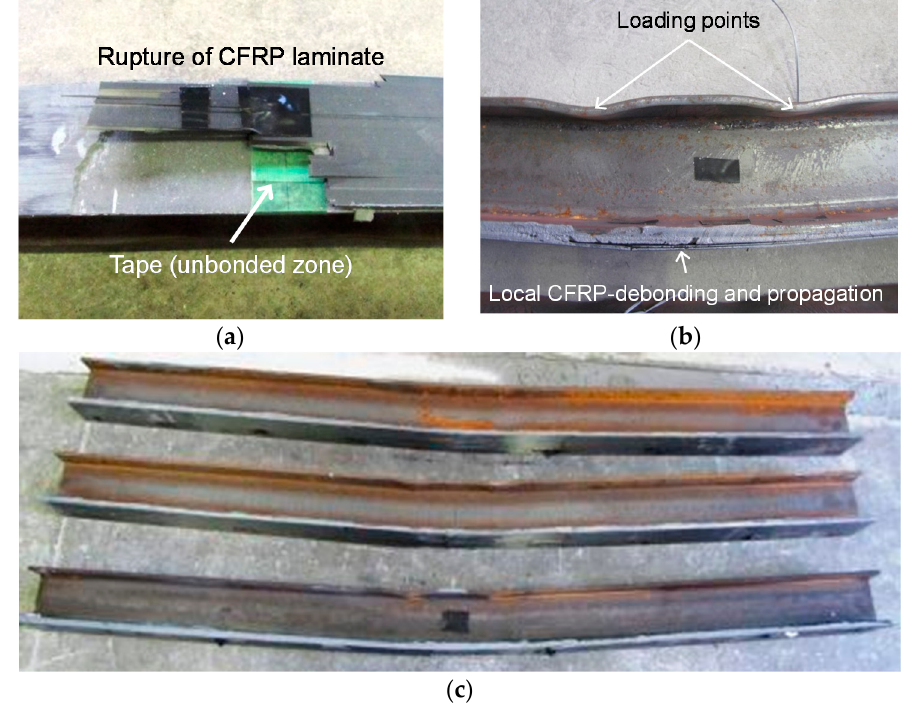
Figure 10. Failure of strengthened beams: ( a ) rupture of CFRP laminate; ( b ) Beam B0; ( c ) Beams B10, B30 and B50.